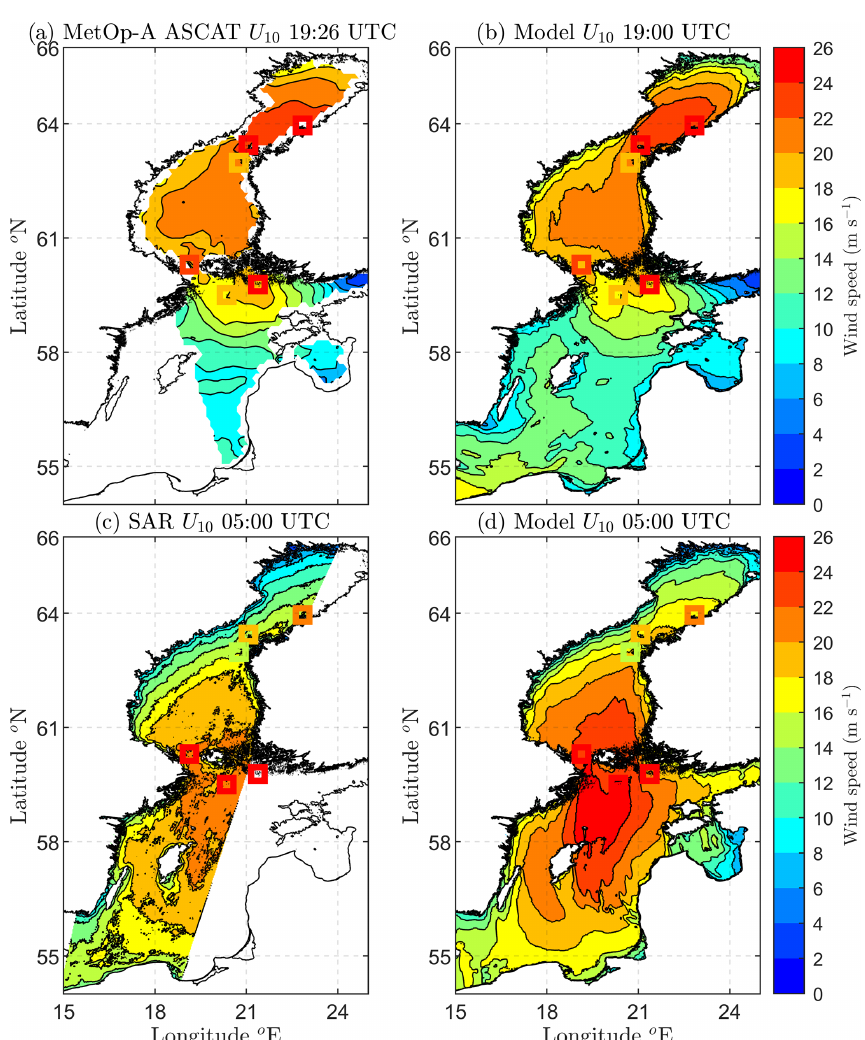
Figure 4. Wind speed U 10 retrieved from a scatterometer and SAR (a, c) and modelled by HARMONIE (b, d) before and after the storm. The overlaid squares correspond to in situ measurements (from north to south): Tankar, Valassaaret, Strömmingsbäadan, Märket, Utö, and